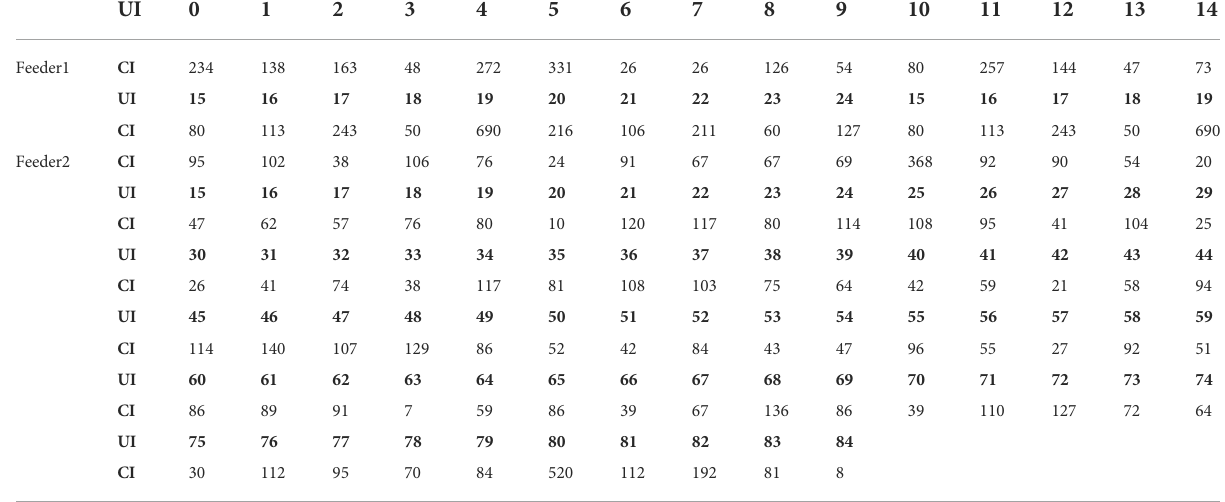
TABLE 2 The CI of users in both